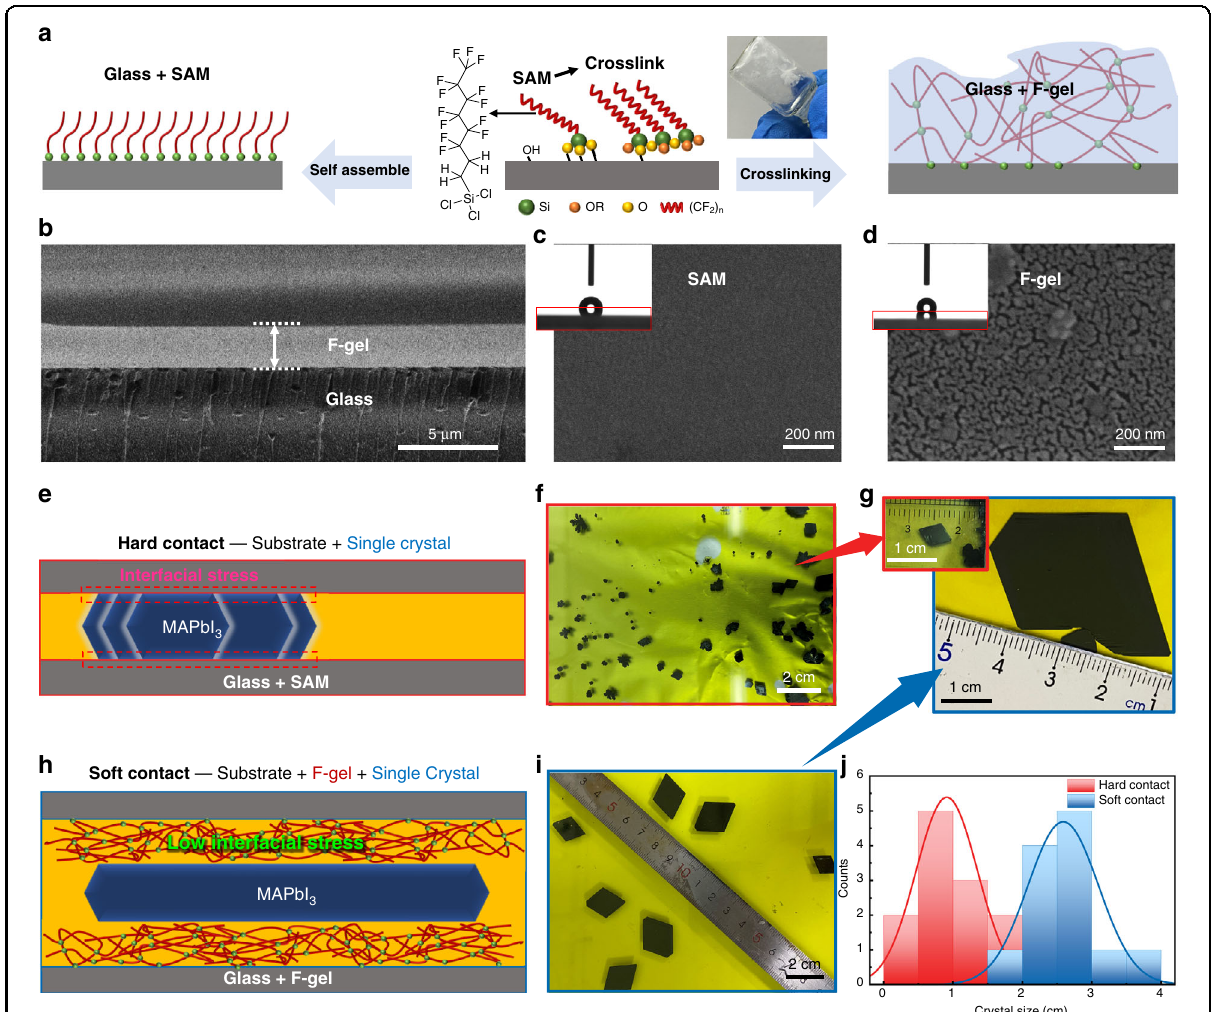
Fig. 1 MAPbI 3 SC growth on different substrates. a Schematic diagram of the formation process of F-gel and SAM on the substrate. SEM images of the b cross-section of the F-gel, c SAM surface and d F-gel surface; (inset of ( c ) is the GBL liquid drop on the SAM substrate, inset of ( d ) is the GBL liquid drop on the F-gel substrate). e Schematic diagram and f picture of crystal growth on SAM substrate. g Typical enlarged photos of crystal growth on SAM (top) and F-gel (bottom) substrates. h Schematic diagram and i picture of crystal growth on the F-gel substrate. j Size statistics of crystals grown on hard and soft contact